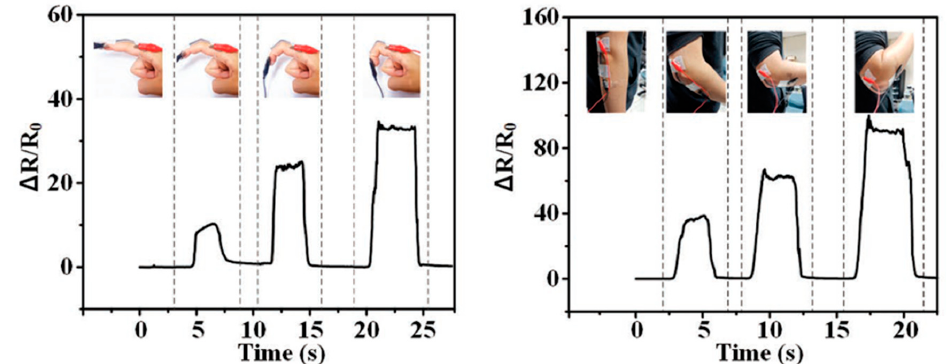
Figure 9. Demonstration of a resistive strain sensor using overlapped CNTs to track bending of the finger and elbow, respectively. Reproduced with permission from [221]. Copyright 2019, John Wiley and Sons.